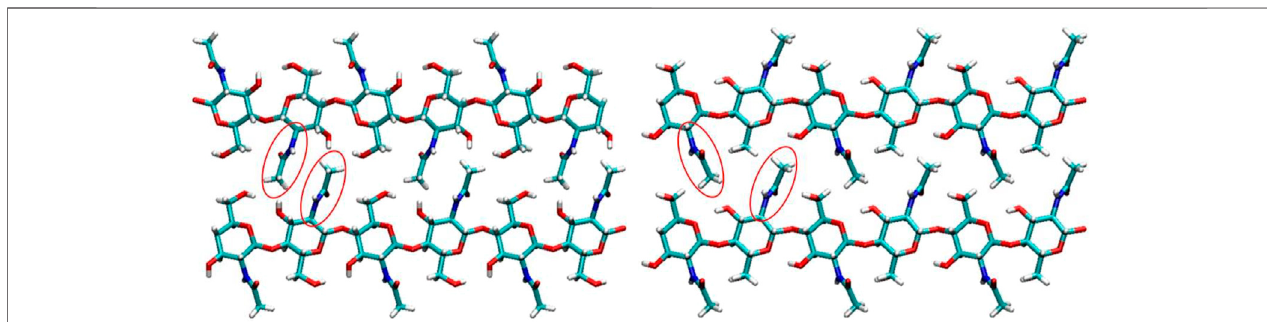
FIGURE 6 | The molecular structure of α chitin (left) and β chitin (right) . Each atom is colored according to its type, with red for oxygen, cyan for carbon, blue for nitrogen, and white for hydrogen.